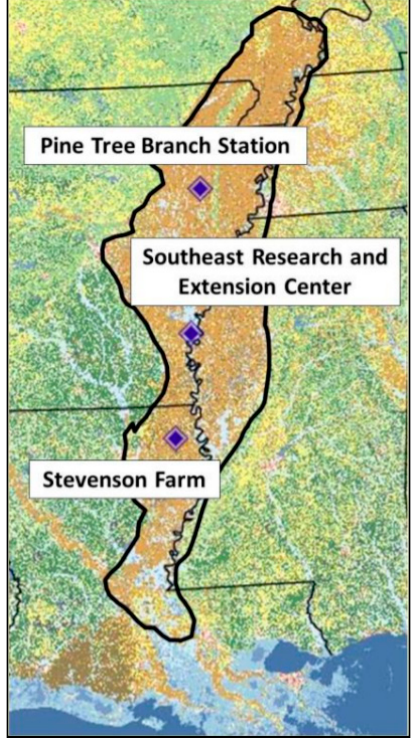
Figure 1. Study site locations [35].